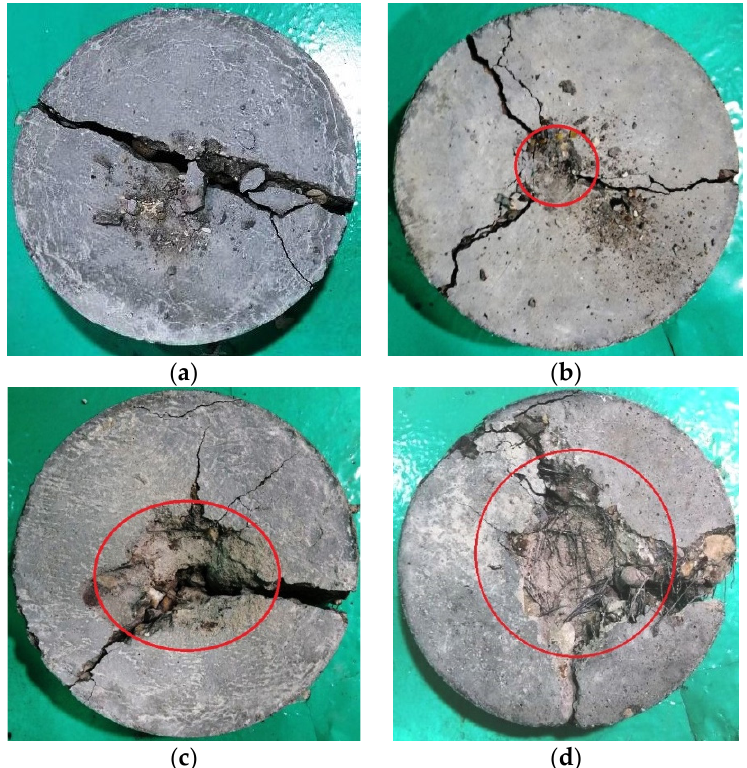
Figure 14. Failure patterns of heated specimens. ( a ) 0% FS line cracking; ( b ) 0% FS diagonal cracking; ( c ) 0.5% FS; ( d ) 1.0% FS.